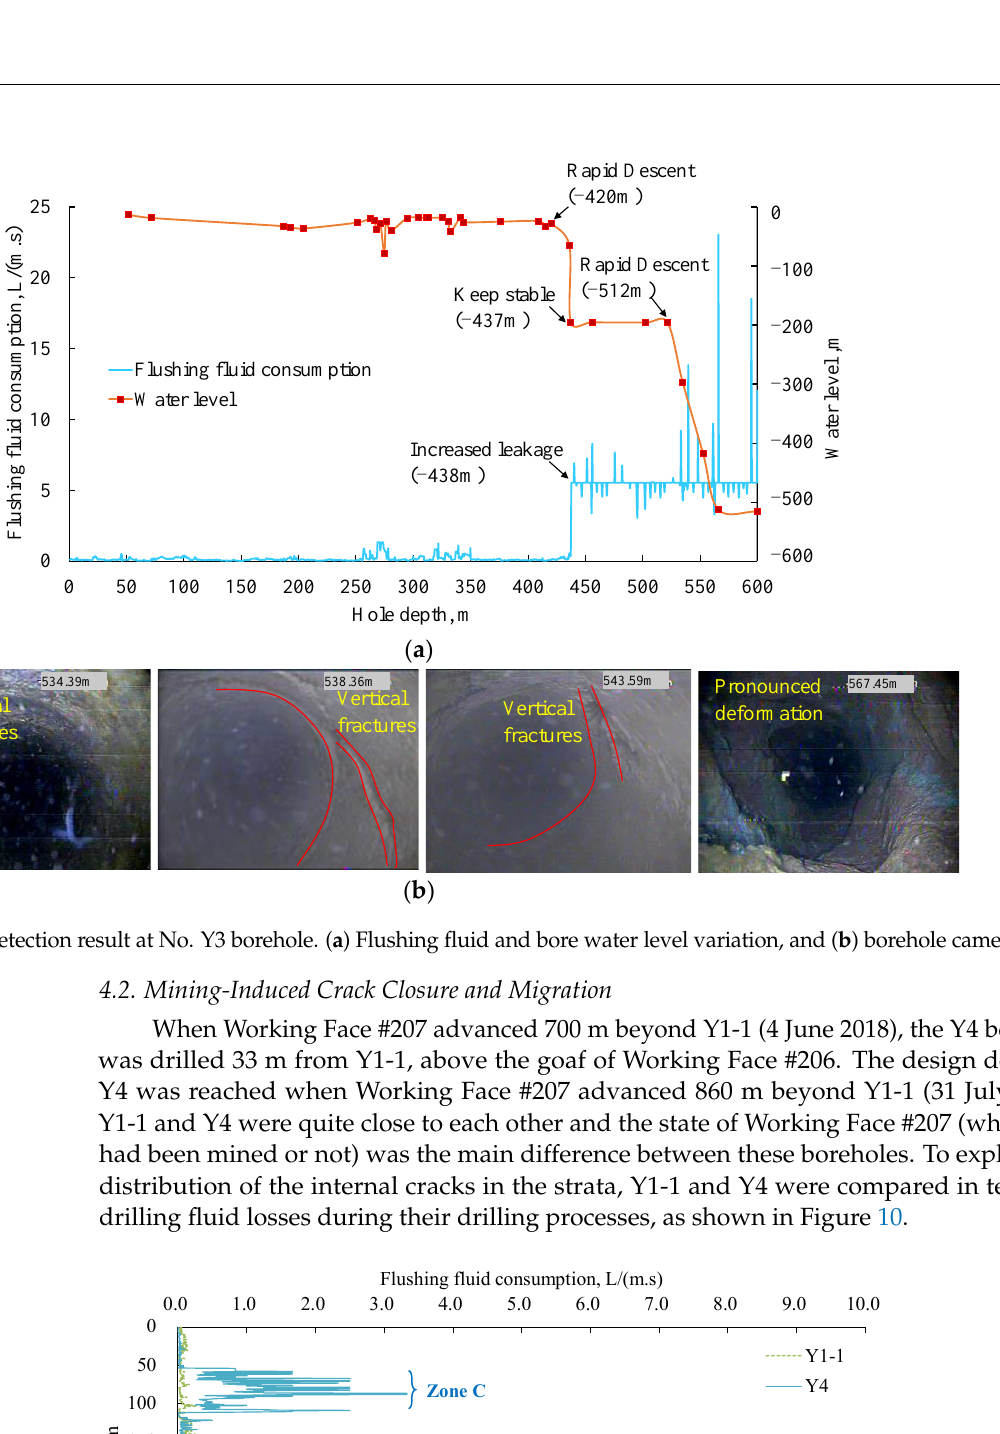
Figure 9. In situ detection result at No. Y3 borehole. ( a ) Flushing fluid and bore water level variation, and ( b ) borehole camera .